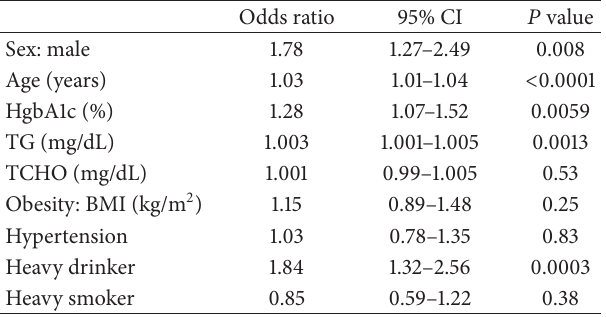
Table 6: Predictors for colorectal